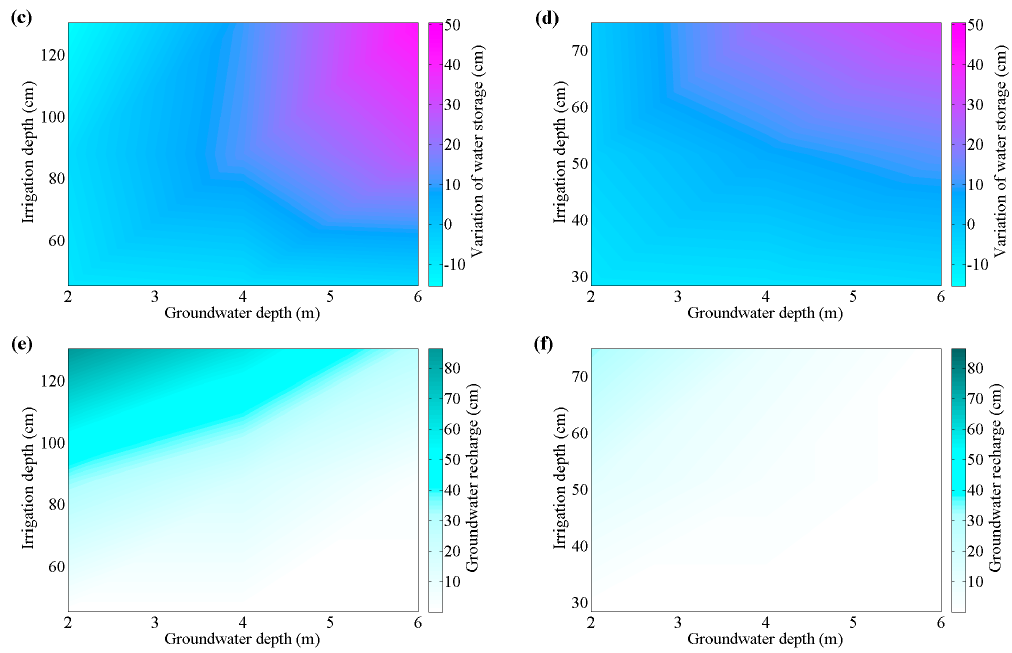
Figure 8. Results of evapotranspiration for maize ( a ) and spring wheat ( b ), variation of soil water storage in vadose zone for maize ( c ) and spring wheat ( d ), and groundwater recharge for maize ( e ) and spring wheat ( f ) in different irrigation quota under various groundwater depths.